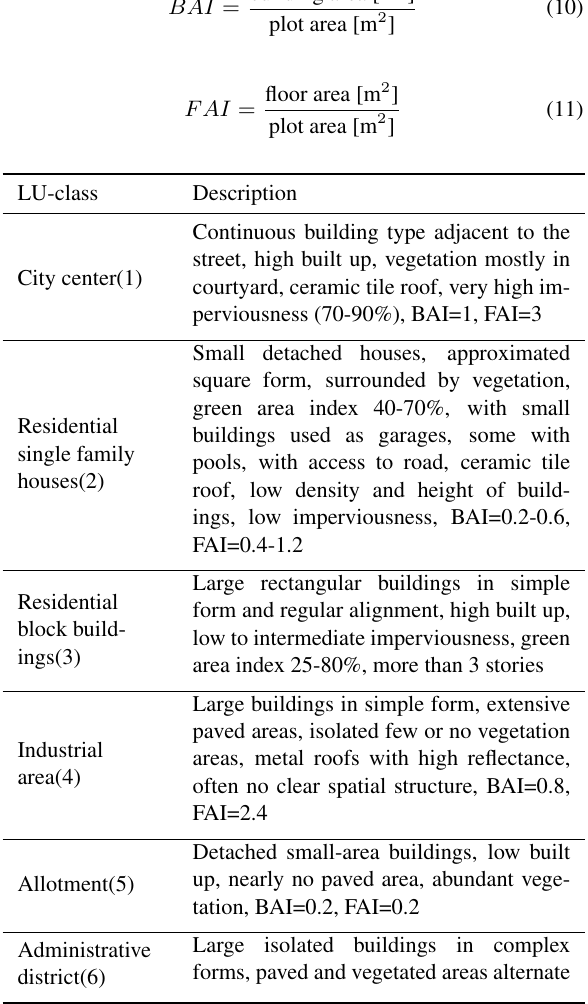
Table 1: Urban land use classes